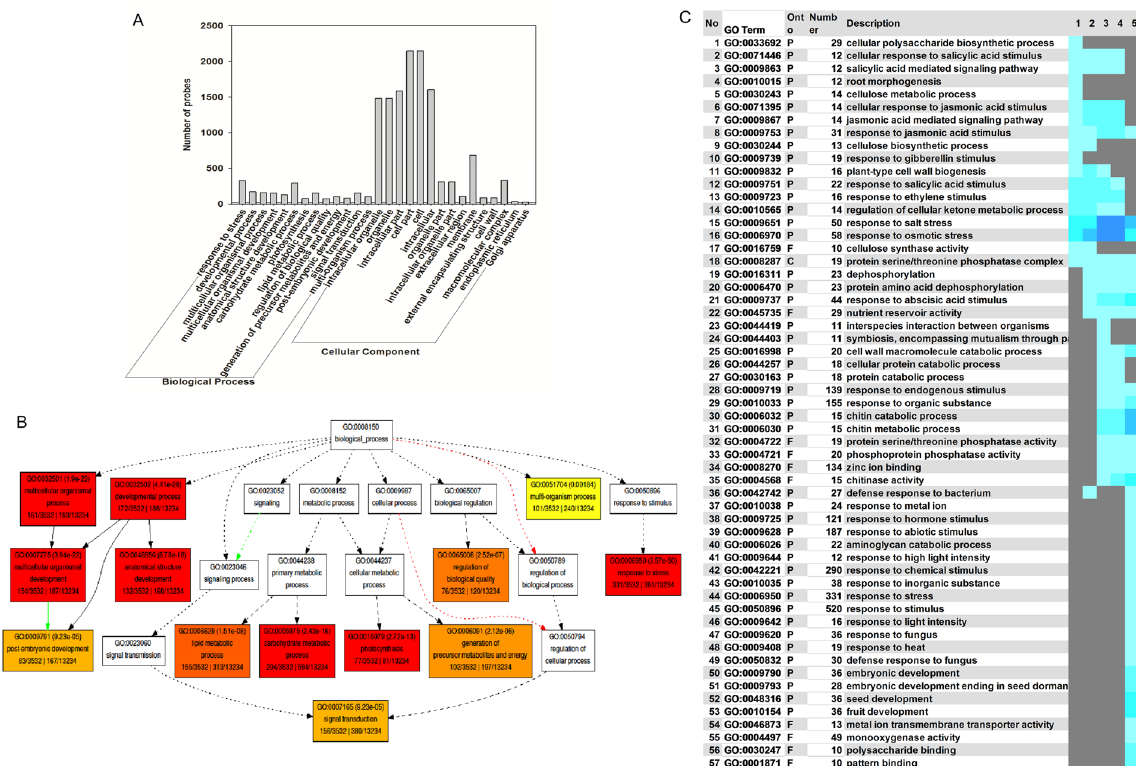
Figure 4. GO enrichment analysis of DEGs at six different time-points during MC development in M . truncatula . ( A ) GO analysis of DEGs. ( B ) Enrichment GO “Biological process” analysis of the DEGs. See Supplemental Fig. S3 for the “Cellular component” categories. ( C ) The down-regulated GO terms were analyzed by PAGE (Tables S5 and S6). The colored blocks represent the level of up/downregulation of each term at a certain developmental stage. The yellow-to-red, cyan-to-blue, and grayscale represent up-regulation, down- regulation, and no significant change, respectively. Detailed information of each term is provided in Table